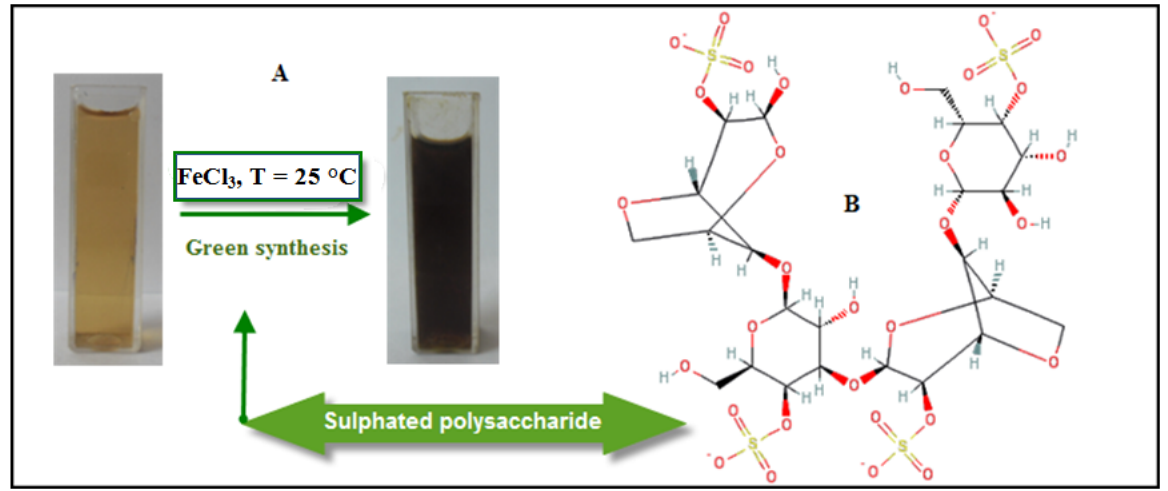
O -NPs in BS 3 4